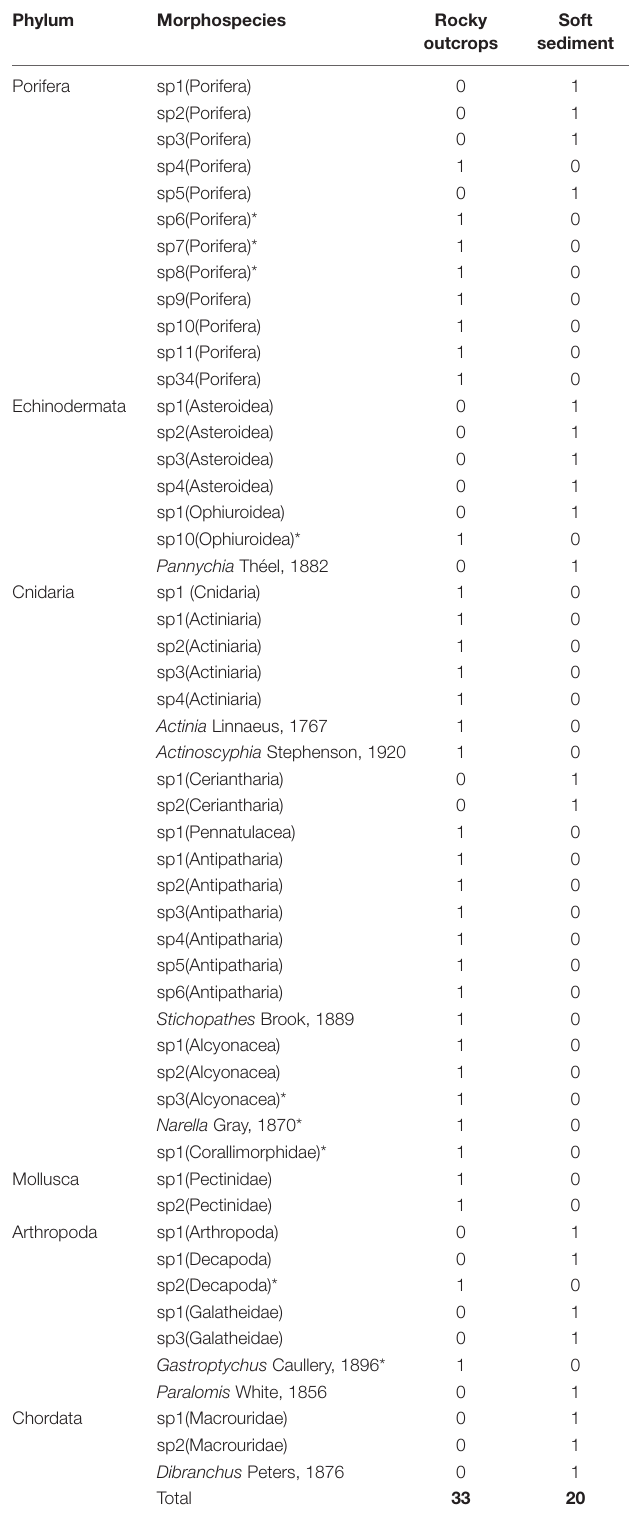
TABLE 5 | Rocky outcrops and soft sediment morphospecies in the NW limit of Guaymas Basin and the Sonoran Margin (849–990 m). Phylum Morphospecies Rocky